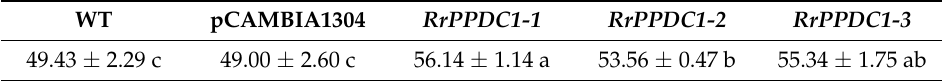
Figure 8. Phenotype and RT-PCR analysis of wild-type and RrPPDC1 transgenic Petunia . ( A , B ) Plant morphology of Petunia plants after 150 days of transplanting; ( C ) mRNA expression of RrPPDC1 in the flowers of transgenic and control Petunia plants; (WT) wild type; (1304) pCAMBIA1304 transgenic plants; (W) Water; (1–3) transgenic plants. Table 1. The corolla diameters of RrPPDC1 transgenic and control Petunia flowers